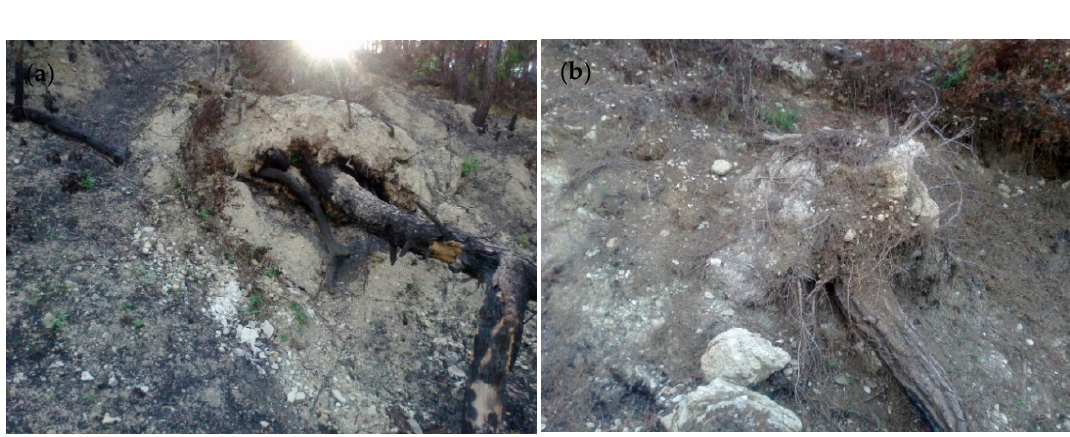
Figure 10. Photos of soil erosion in burned forests at steep slopes in ( a ) Yamada and ( b ) Rabia.